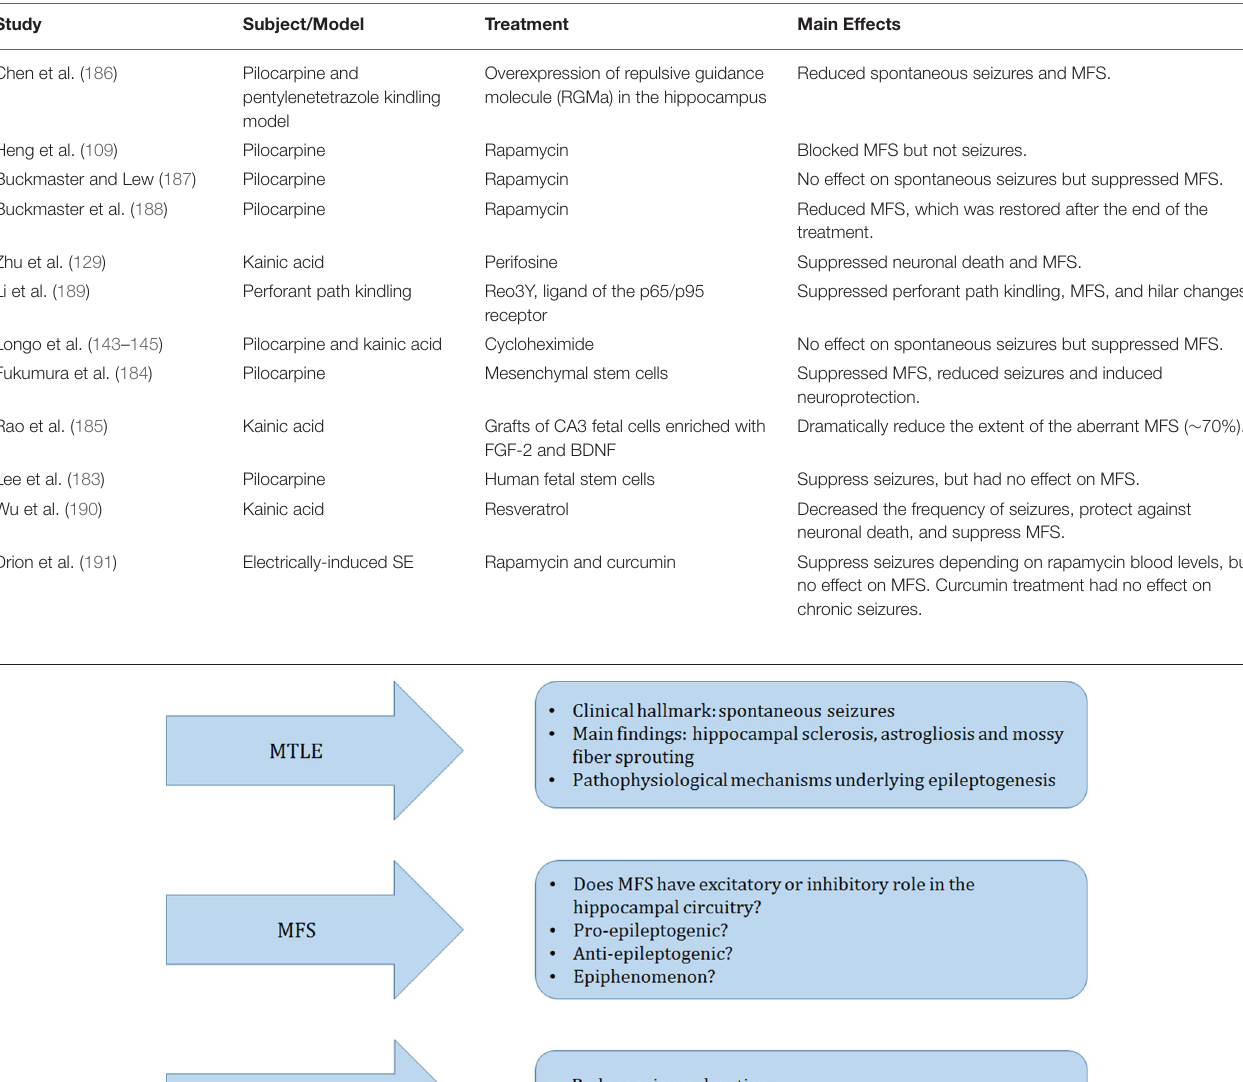
TABLE 1 | Treatment effects on seizure frequency and MFS.